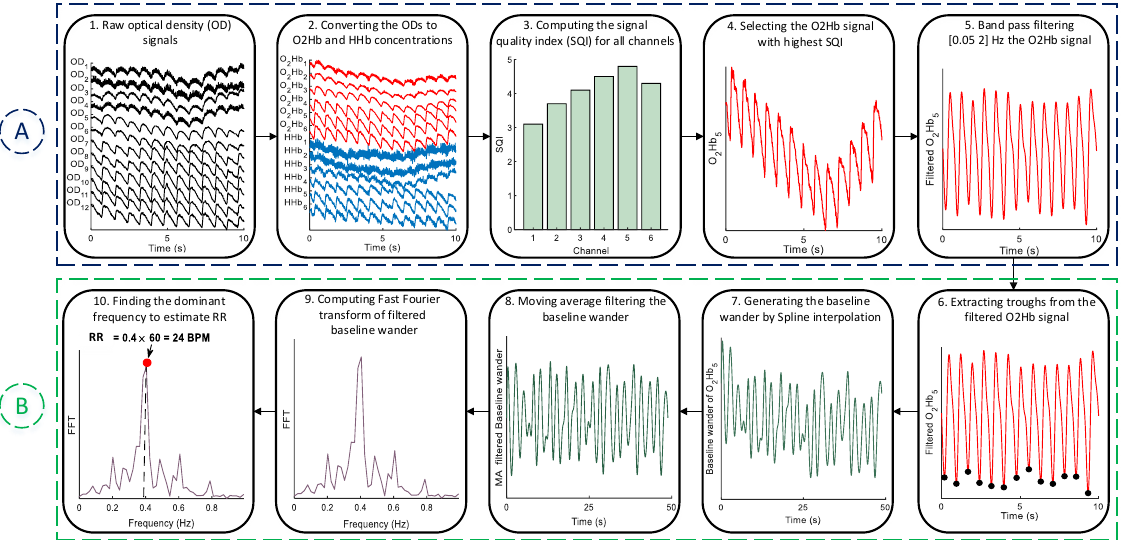
Figure 1. The block diagram of the proposed method. It should be noted that for the sake of clarity, fNIRS signals are shown only for 10 s.